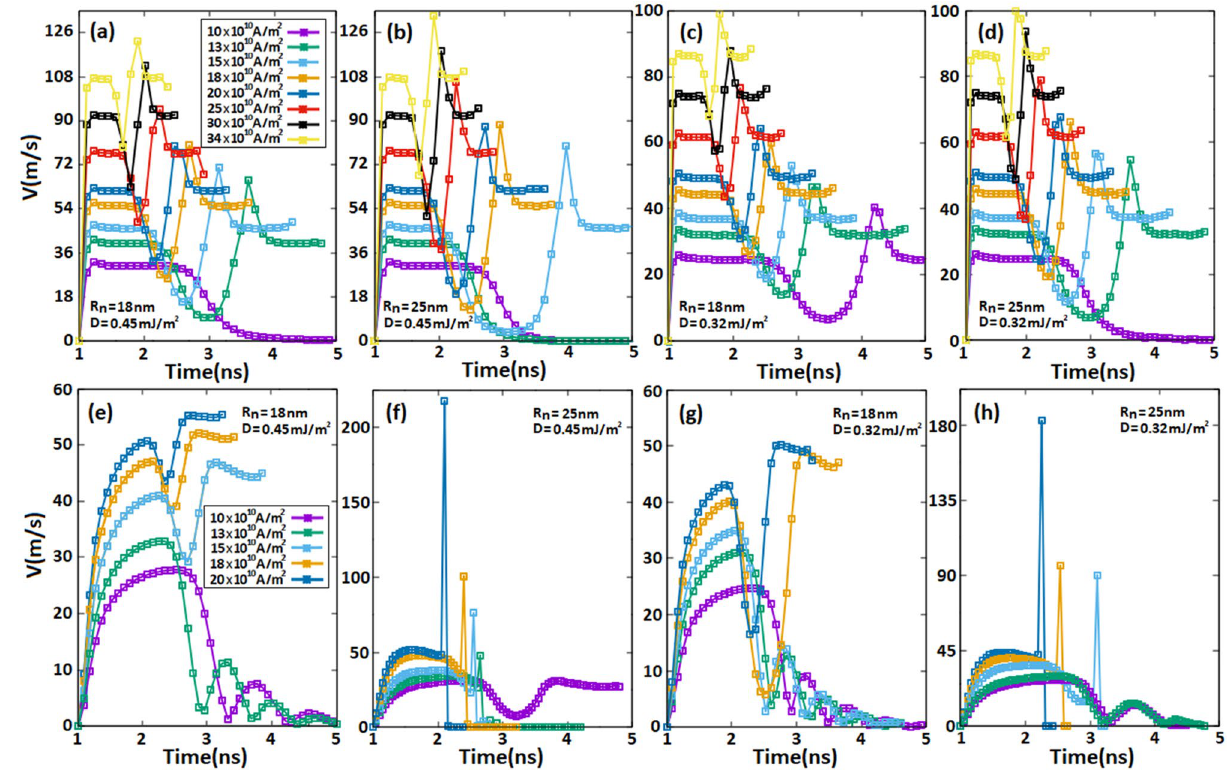
Figure 9. Temporal evolution of ( a–d ) the AFM skyrmion velocity and ( e–h ) the FM skyrmion velocity for various SOTs along the racetrack memory with different skyrmion and notch